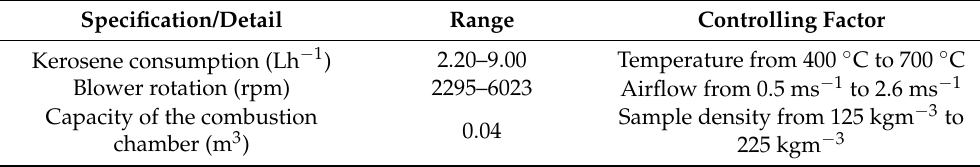
Figure 2. ( a ) 3D diagram of the prototype hybrid rice husk burner (PHRB) and ( b ) prototype hybrid rice husk burner. (PHRB) (1. Displaying and controlling unit, 2. Kerosene burning unit, 3. Hot air preparation unit, 4. Rice husk combustion chamber, 5. Exhaust fan, 6. Exhaust duct, 7. Kerosene tank 8. Blower, 9. Temperature sensors, 10. Exhaust outlet for combustion stage, 11. Exhaust outlet for hot air preparation stage, 12. Air releasing lever). Table 1. Specifications of prototype hybrid rice husk burner (PHRB) with a fluidized bed.